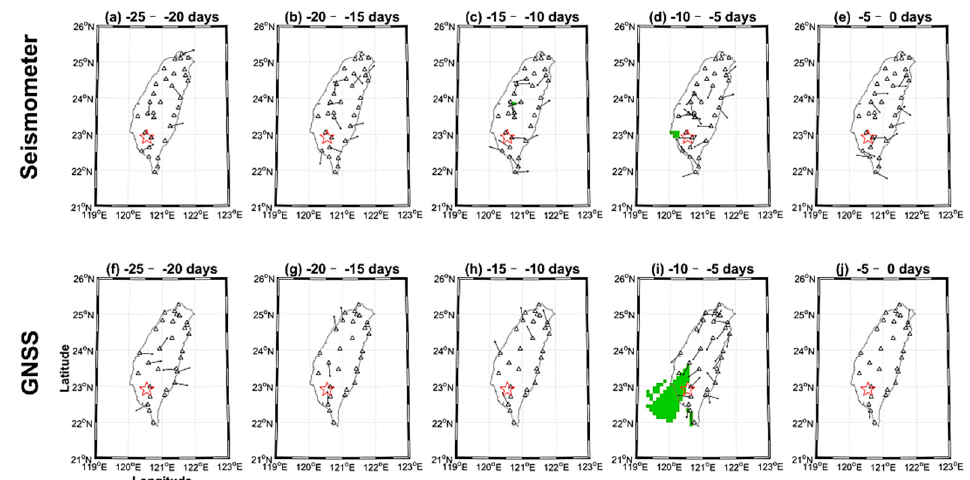
Figure 4. Locations of the vibration sources determined using seismic and GNSS data for an interval of 0–25 days before the Meinong earthquake. The upper and lower panels show locations obtained from seismic and GNSS data, respectively, in distinct time spans following ( a – j ). Black arrows lie on stations with significant amplitude enhancements, as shown in Figure 3, and point toward potential sources of crustal vibration excitation before the earthquake. The red star denotes